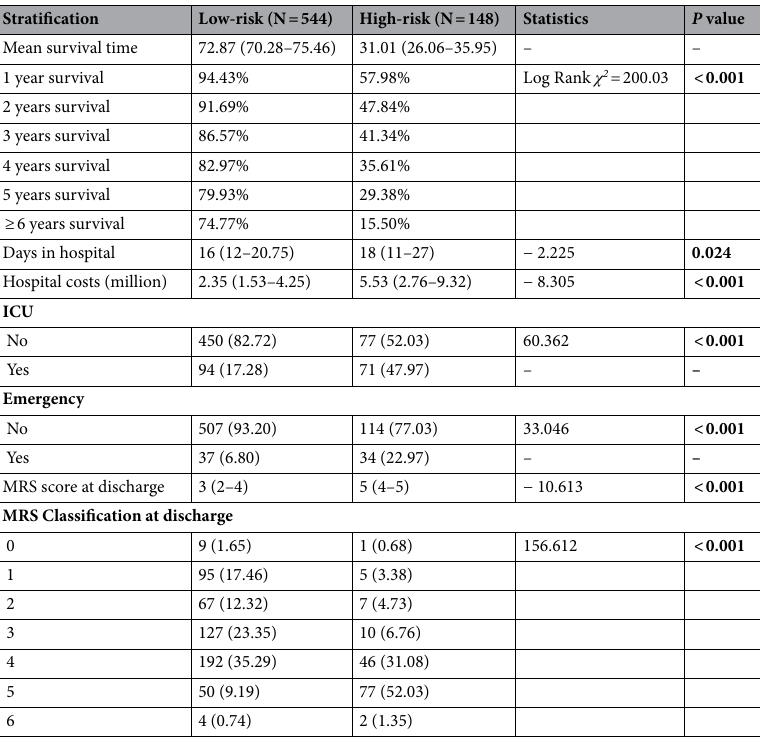
Table 2. Survival information of each risk stratification. Significant values are in